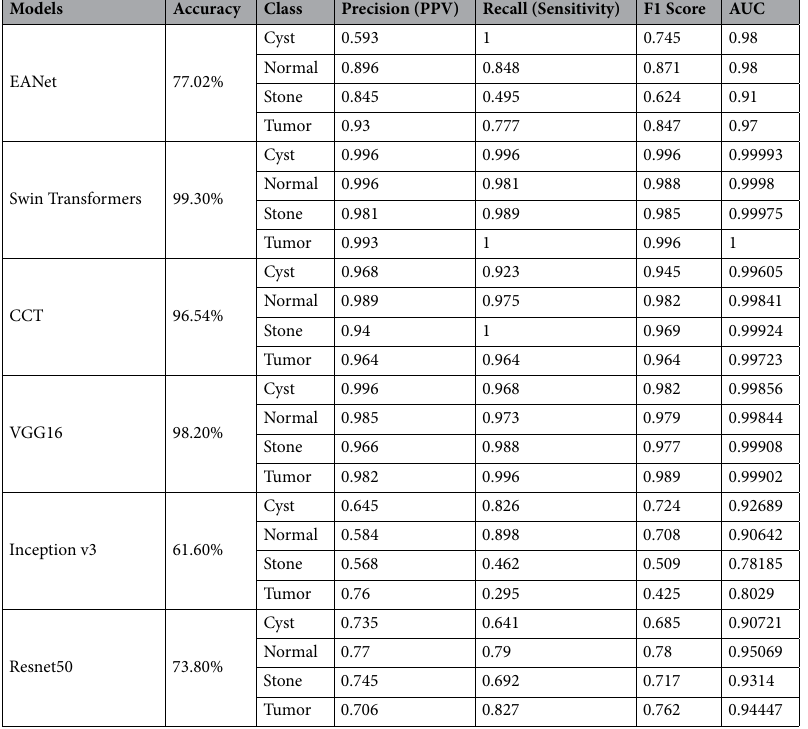
Table 2. MEASURES OF PERFORMANCE FOR THE SIX MODELS STUDIED IN THE RESEARCH.